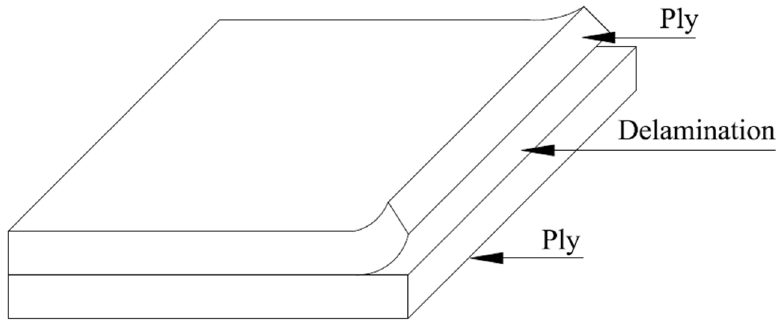
Figure 19. Separation of adjacent layers due to weakening of interface layer between them.